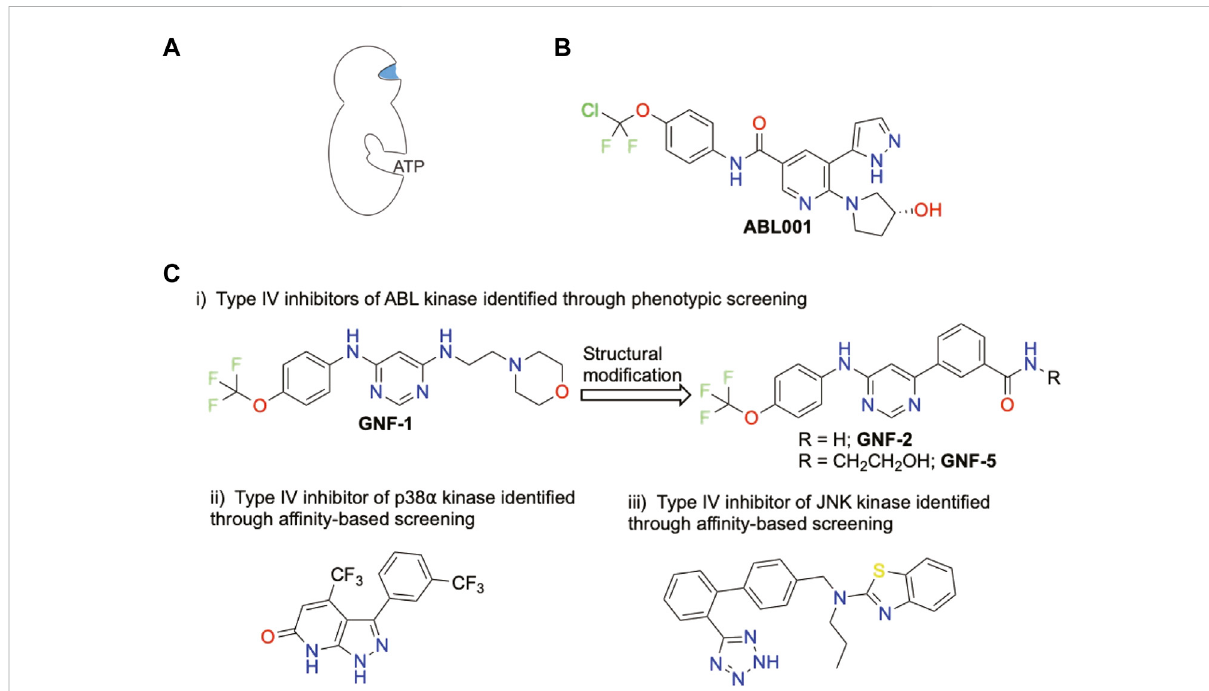
FIGURE 4 Representative chemical structures displaying a kinase inhibitory activity of Type IV and their potency toward speci fi c kinases. (A) Schematic representation of Type IV allosteric site. Blue color indicates targetted site. (B) Only FDA-approved Type IV inhibitor (C) Other Type IV